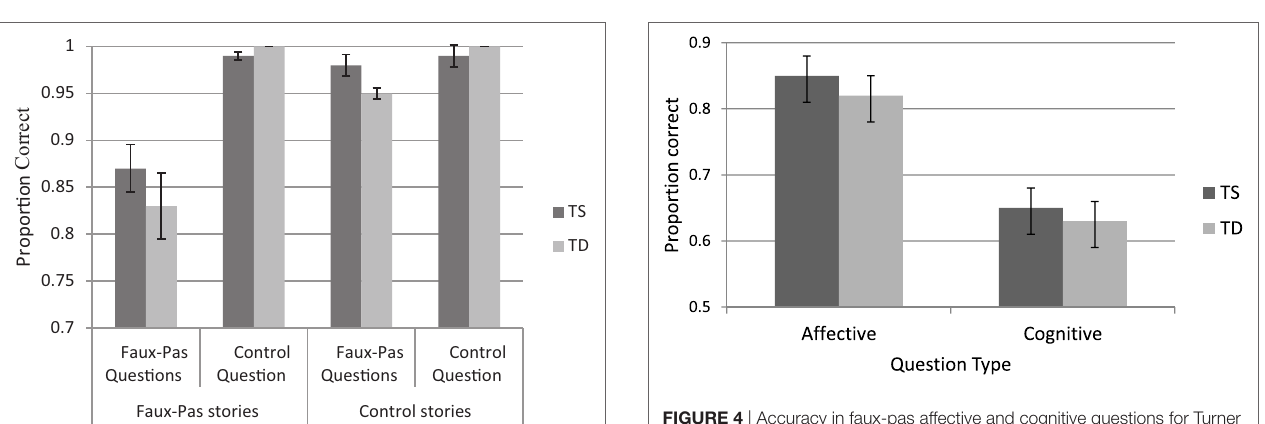
FigUre 4 | Accuracy in faux-pas affective and cognitive questions for Turner syndrome (TS) and typically developing (TD)